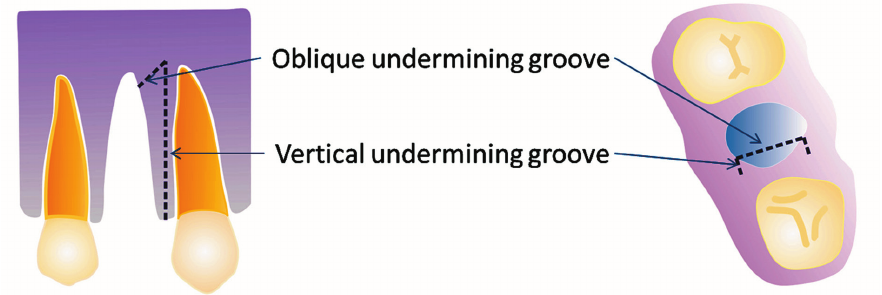
Figure 3- Surgical techniques for undermining interseptal bone distal to the canine. No cuts are performed on buccal and lingual plates. Note depths and positions of undermining grooves